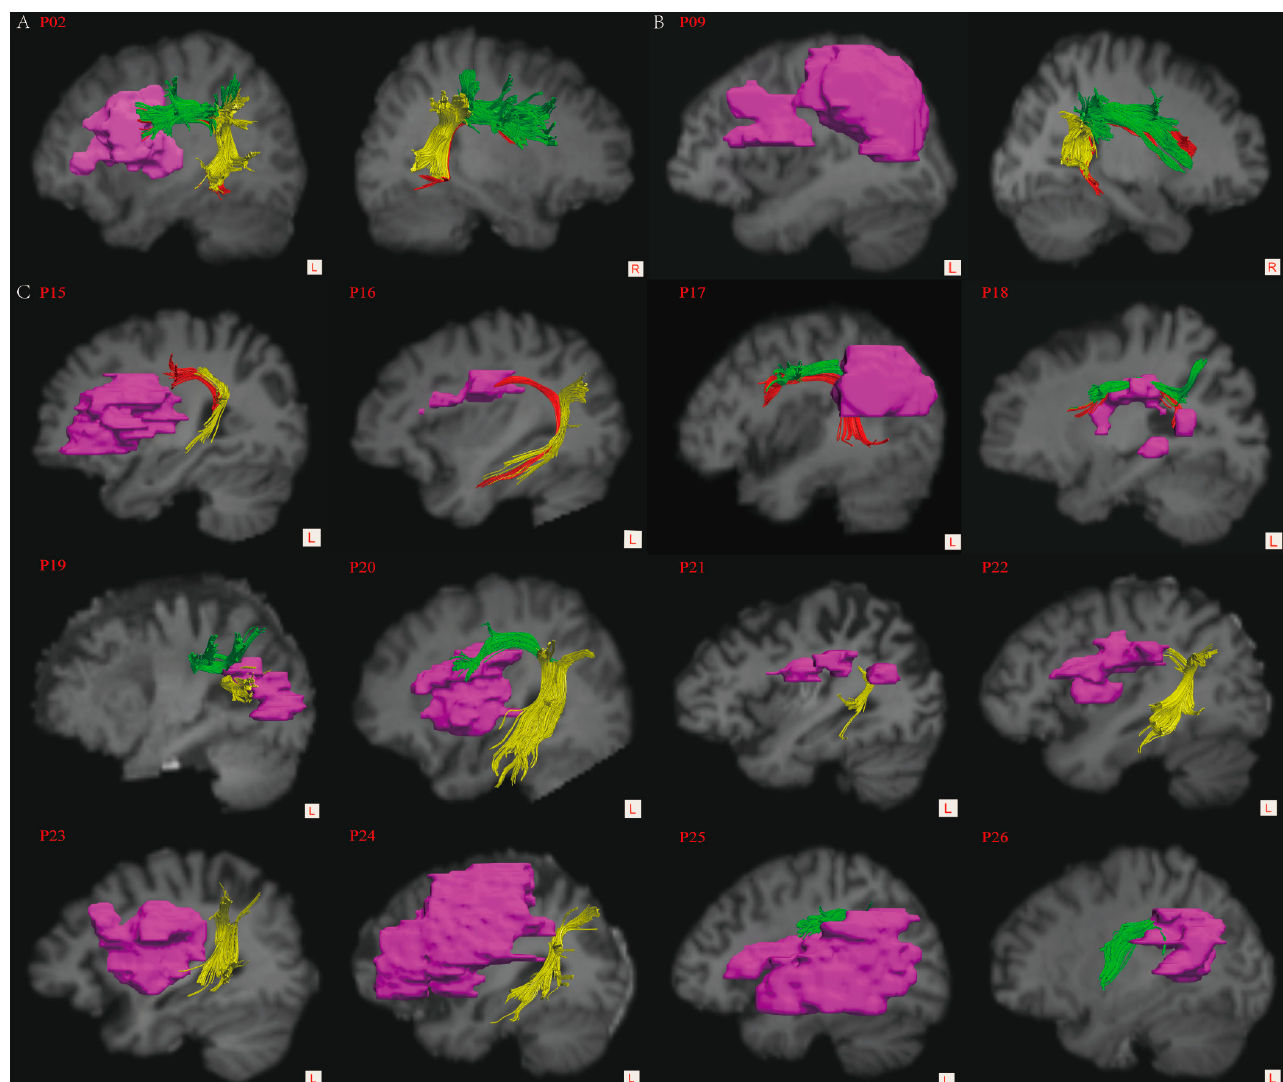
Figure 2. The reconstruction of the left arcuate fasciculus (AF). ( A ) A sample of the completely reconstructed left AF according to the 3-ROIs approach in group A; ( B ) a representative of the non- reconstructed left AF in group B; and ( C ) all patients with the partially reconstructed left AF in group C. The pink blocks—stroke lesion. In group C, the anterior and LSAF presented with different degrees of damage, despite being partially reconstructed, while the PSAF was relatively less damaged, by contrast.